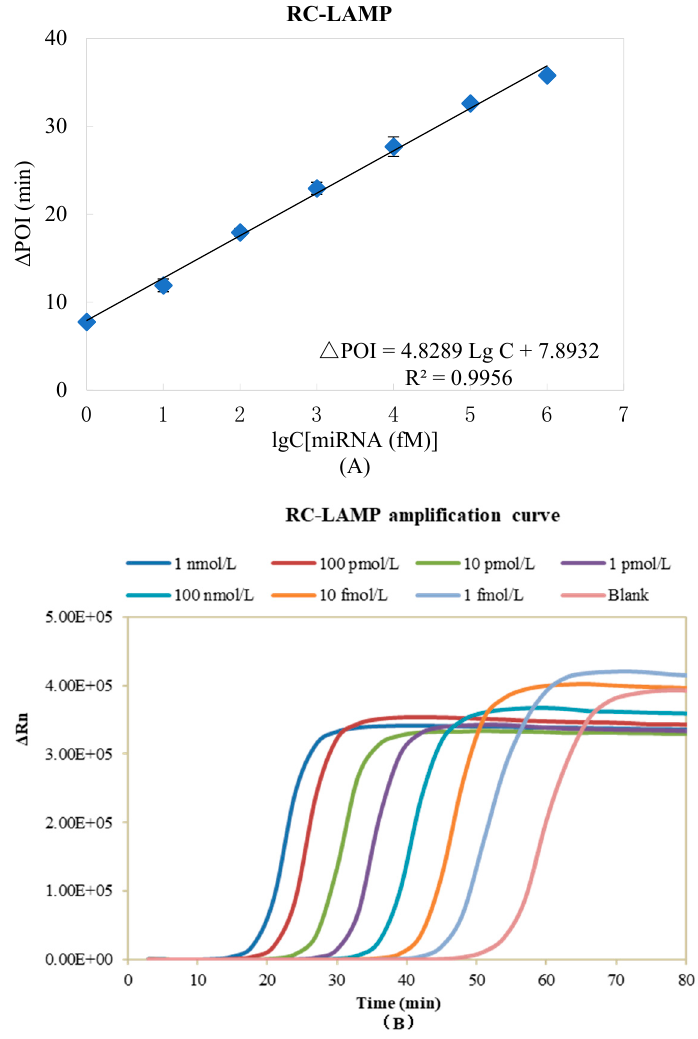
Figure 5. Standard curve of miR-200a detected by RC-LAMP method. ( A ) ∆ POI values vs. logarithm (lg) of miR-200a concentrations. ( B ) Real-time fluorescence curves vs. miR-200a concentrations. Experimental conditions: Padlock probe 20 pmol/L, T4 DNA ligase 70 U, FIP/BIP 800 nmol/L and amplification temperature 62 °C, respectively.